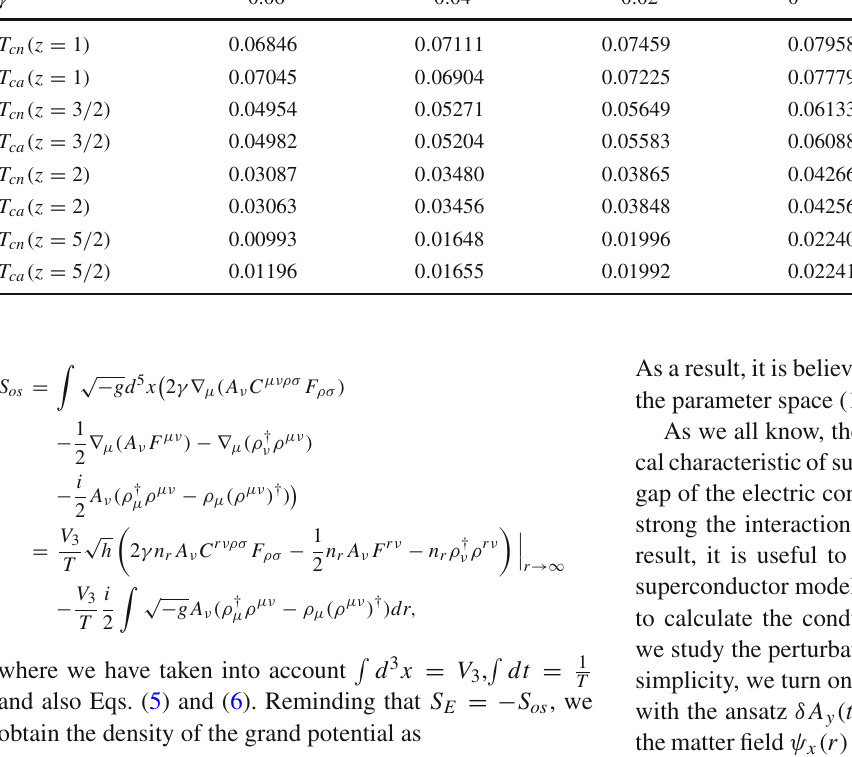
Table 1 The critical temperature in unit of chemical potential μ from the numerical method ( T cn ) and the analytical method ( T ca ) for different value of γ and z γ − 0.06 − 0.04 − 0.02 0